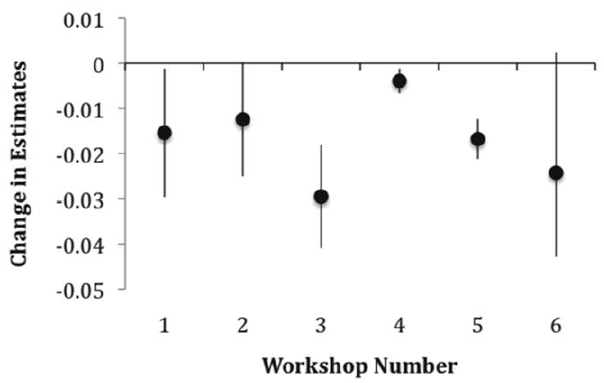
Figure 3. The group average improvement in accuracy (ALRE) following discussion. Change in estimates records distance from the truth, so that more strongly negative values improved more. The dots are the improvements in averages of best guesses. The error bars are